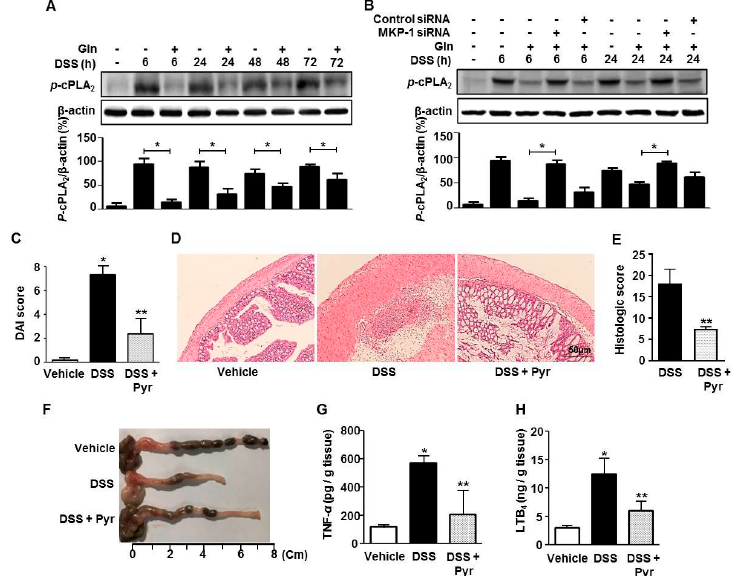
Figure 4. cPLA 2 inhibition is associated with the beneficial effect of Gln. ( A , B ) Immunoblot analysis of cPLA 2 phosphorylation; ( C ) disease severity; ( D ) histological abnormality; ( E ) histological score; ( F ) colon length; colonic levels of TNF- α ( G ) and LTB 4 ( H ); ( A , B ) A representative of three independent experiments ( n = 3 mice/group/time point). * p < 0.05 vs. DSS only group in ( A ); * p < 0.05 vs. DSS + Gln group in ( B ); Data in ( C , G , H ) represent the means ± SEM of three independent experiments ( n = 5 mice/group/time point); ( D – F ) A representative from three independent experiments ( n = 3 mice/group/time point) is shown. Scale bar = 50 μ m. * p < 0.001 vs. vehicle group; ** p < 0.05 vs. DSS group in ( C , E , G , H ).